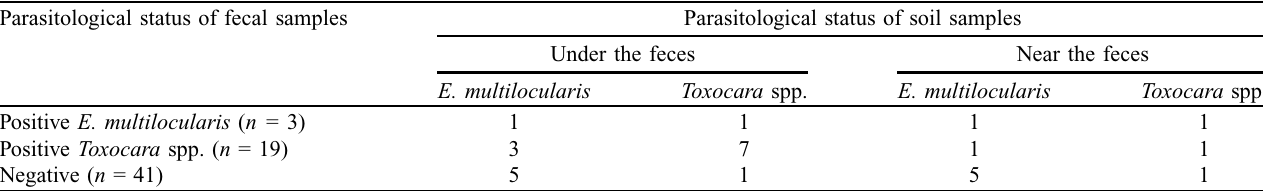
Table 3. Parasitological status for E. multilocularis and Toxocara spp. of fecal and soil samples depending on their position under or near the feces.